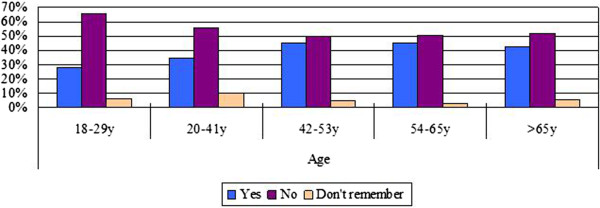
Heat-related illness by age groups.